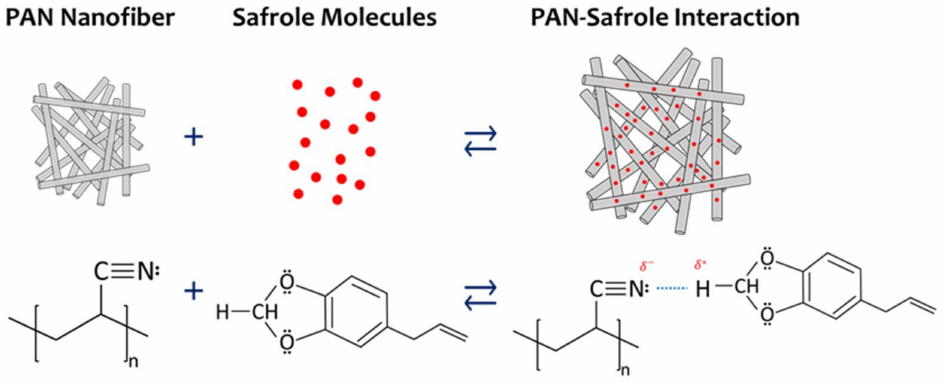
Figure 9. Schematic representation of the interaction mechanism between safrole and PAN